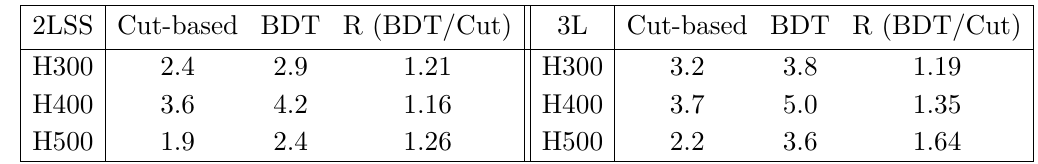
p Table 8 . Comparison of the signi(cid:12)cance S= S + B for the cut-based analysis and the BDT ap- proach. In the 4th and 8th columns, the quantity R (BDT/Cut) equals the ratio of the signi(cid:12)cance of the BDT approach over that of the cut-based